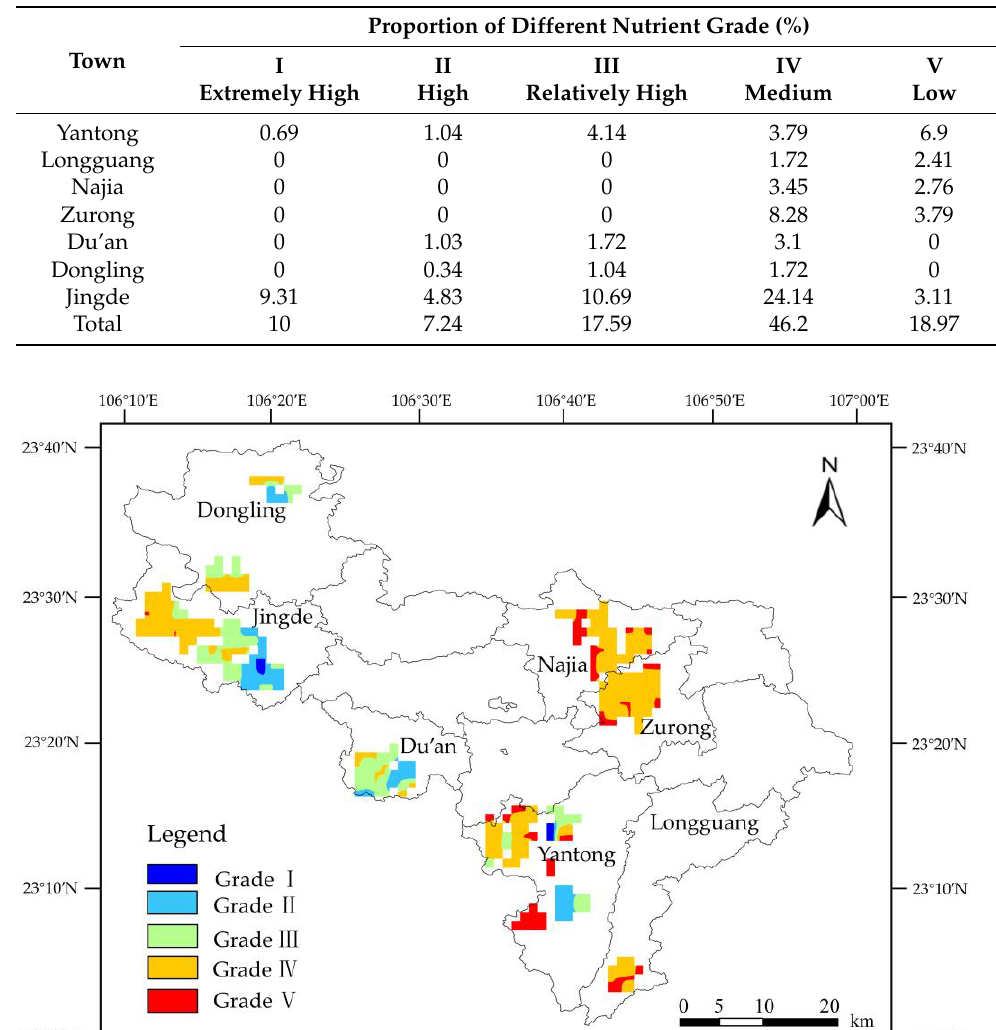
Table 5. Evaluation of nutrient status based on the LightGBM model.